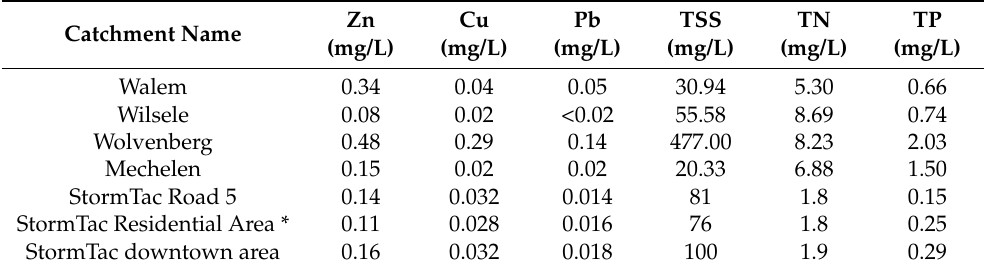
Table 3. Average pollutant concentrations in the four catchments, compared with average concentra- tions in the StormTac database [14].